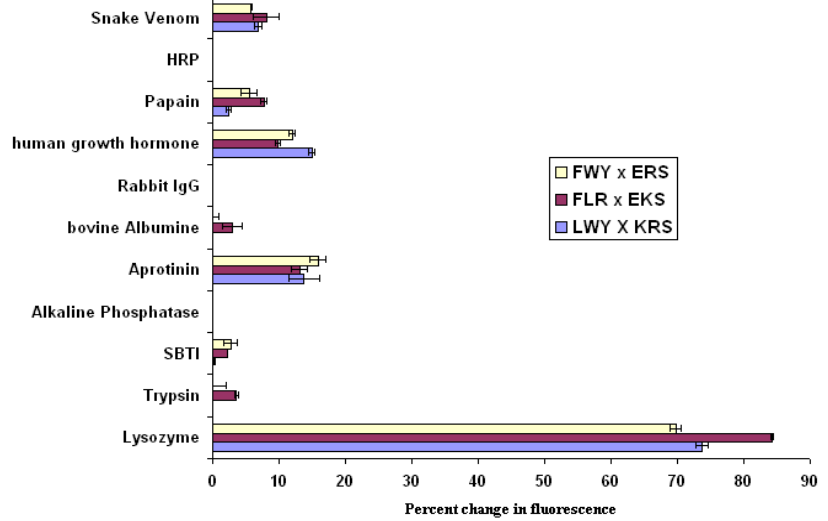
interactions as a diagnostic tool; error bars represent high and low values.